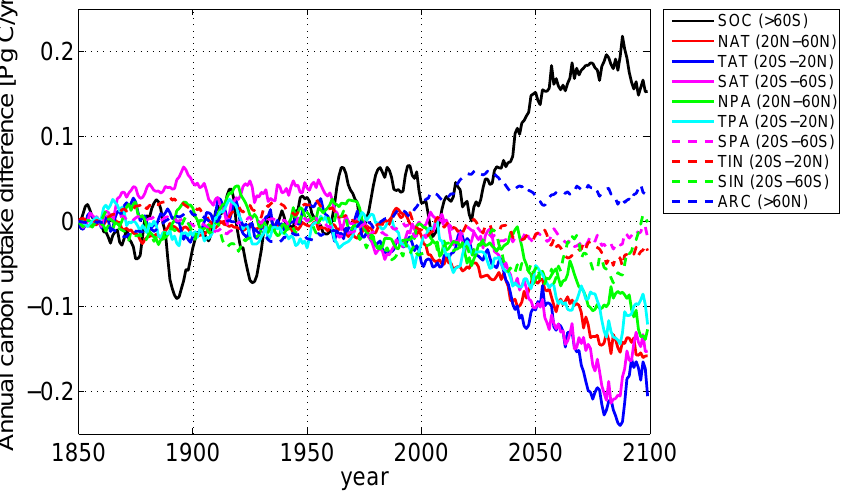
Fig. 9. Coupled minus uncoupled (COU-UNC) of spatially-integrated annual oceanic carbon uptake (10-year running mean). Regions are defined as follow: Southern Ocean (SOC), North Atlantic (NAT), Tropical Atlantic (TAT), South Atlantic (SAT), North Pacific (NPA), Tropical Pacific (TPA), South Pacific (SPA), Tropical Indian (TIN), South Indian (SIN), and Arctic